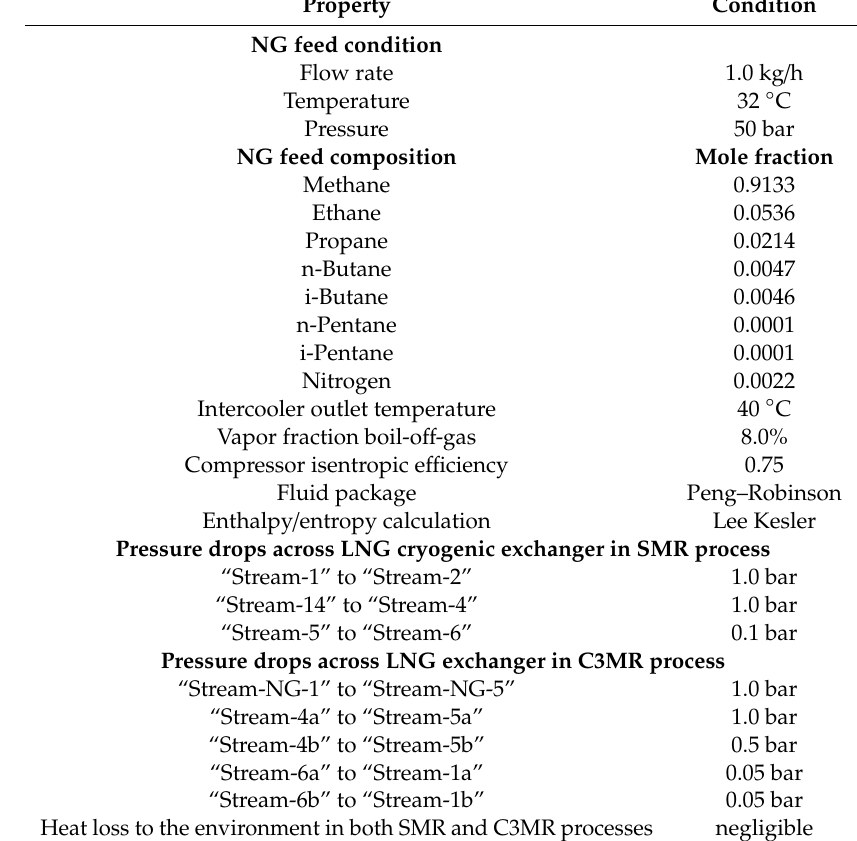
Table 2. Natural gas feed conditions and assumptions for Hysys modeling of the SMR and C3MR. Property